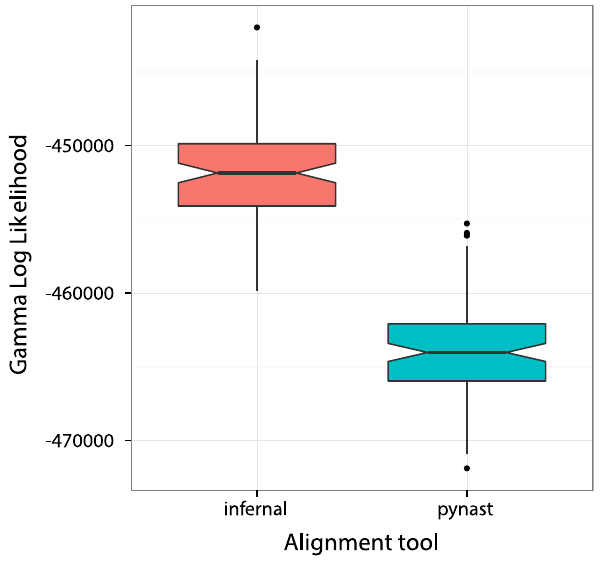
Fig. 1. Comparison of alignment tools. Plot of Gamma Log Likelihoods of 100 trees created from paired reads selected from the Greengenes 13 – 5 database, and aligned using PyNAST and Infernal version 1.1. Likelihoods in the trees created using Infernal are significantly better than the trees created with PyNAST ( p , 0.0001, Wilcoxon signed ranked test), strongly suggesting that Infernal produces better quality alignments than PyNAST for the same input